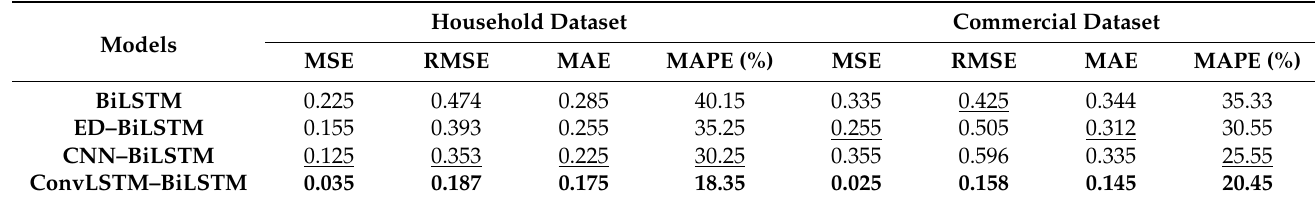
Table 5. Performance of the proposed models on day resolution.